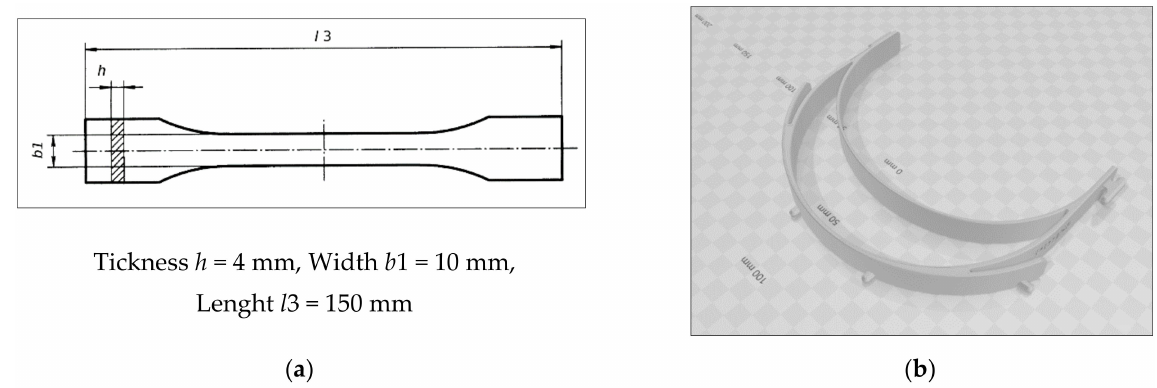
Figure 2. 3D models: ( a ) the sample; ( b ) the face shield